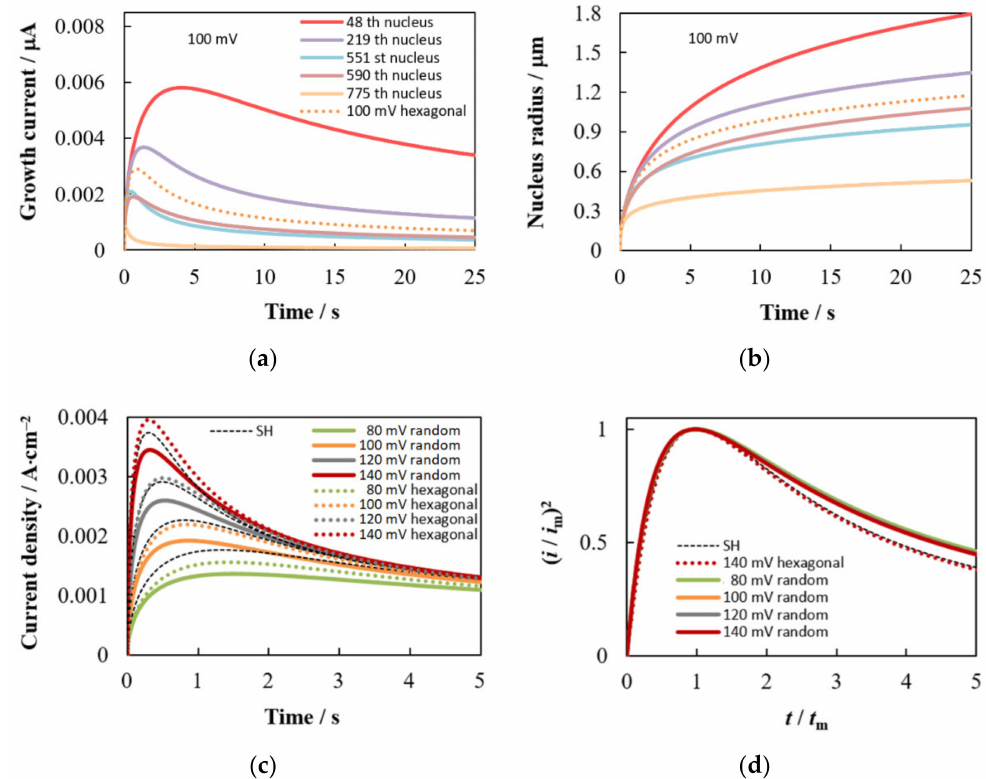
Figure 7. ( a ) Time dependences of the growth current, ( b ) time dependences of the nucleus radius for five nuclei highlighted in Figure 2a; ( c ) Comparison of the total current density transients for random and hexagonal ensembles with the SH model at the same number density of nuclei; ( d ) Dimensionless dependencies for data of ( c ). The same designations of colored lines are used in ( a , b ). Parameter values are given in Section 2.3 and Table